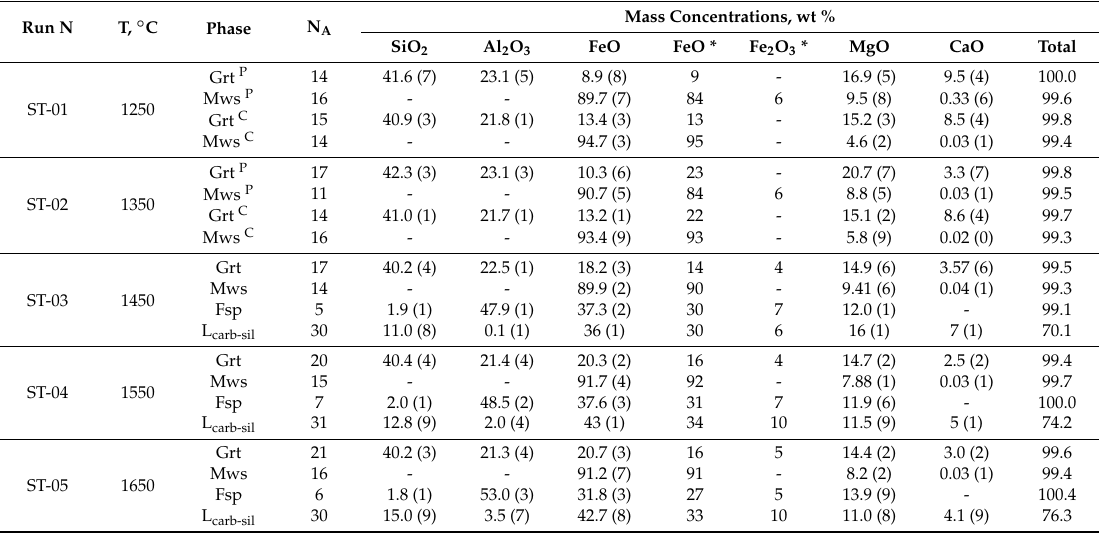
Figure 2. SEM-micrographs (BSE-regime) of polished fragments of the samples (”sandwich”-type experiments, 7.5 GPa): ( a ) cohenite, magnesiowustite, garnet and graphite assemblage (reduced part of the sample, 1250 °C); ( b ) large graphite crystal with inclusions of cohenite and magnesiowustite, in a garnet + magnesiowustite + graphite aggregate (1550 °C); ( c ): growth patterns at (111) face of the diamond seed (1350 °C); ( d ) garnet and graphite in the quenched carbonate–silicate melt (1550 °C); ( e ) garnet in the quenched carbonate–silicate melt, at the contact with magnesiowustite + garnet + graphite polycrystalline aggregate (1450 °C); and ( f ) garnet, graphite and ferrospinel crystals in the quenched carbonate–silicate melt (1550 °C); Grt, garnet; Coh, cohenite; Mws, magnesiowüstite; Fsp, ferrospinel; Gr, graphite; L carb-sil , carbonate–silicate melt. Table 5. 57 Fe Mössbauer data for silicates, carbonates, oxides and melts. Table 4. Average compositions of silicates and oxides in the carbide–oxide–carbonate system (“sandwich-type” experiments) at 7.5 GPa, according to microprobe